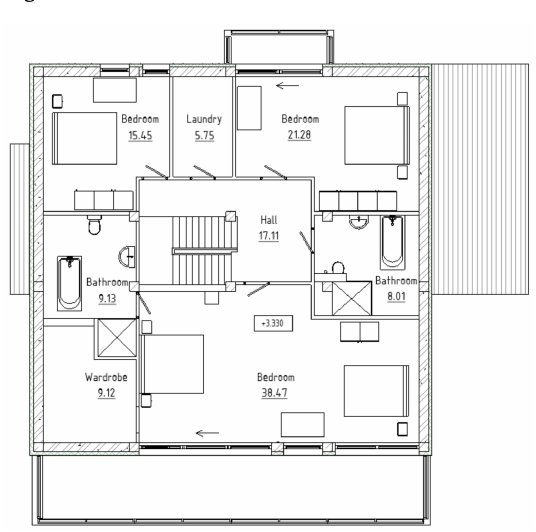
Figure 16. Plan of the second